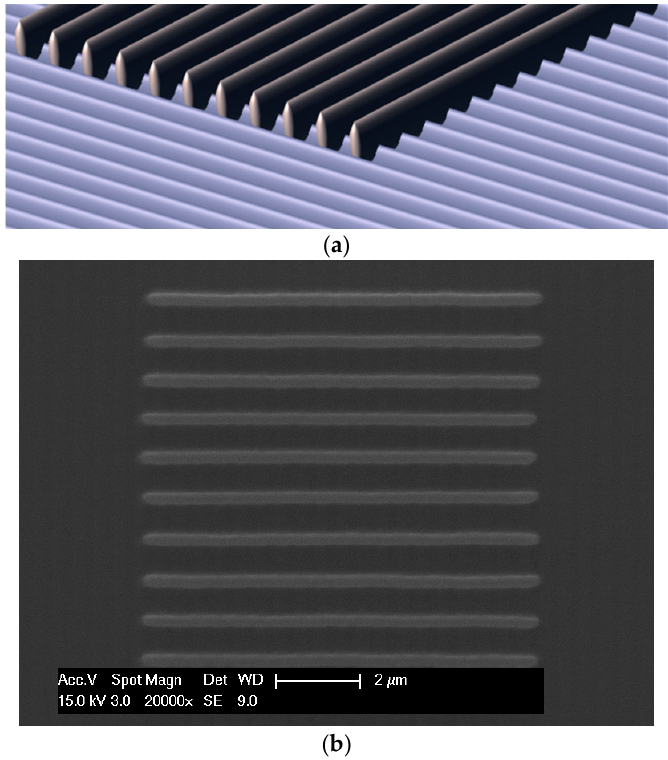
Figure 5. ( a ) A protocol for ensuring level lines was developed by creating an initial set of parallel features, on to which lines for inspection were fabricated; and ( b ) a typical set of fabricated lines (Formulation 6 without degassing, 35 mW).